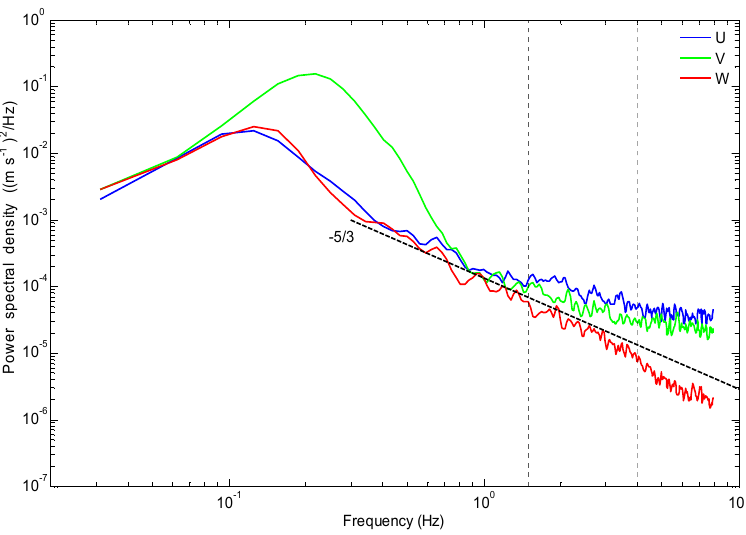
Figure 2. Example of Vector velocity spectra, at a mean depth of 0.7m, for the three components. The inertial dissipation method was applied to the w component across the frequency range 1.5 to 4Hz, shown by vertical dashed lines. The black dashed line indicates the slope of the theoretical Kolmogorov inertial